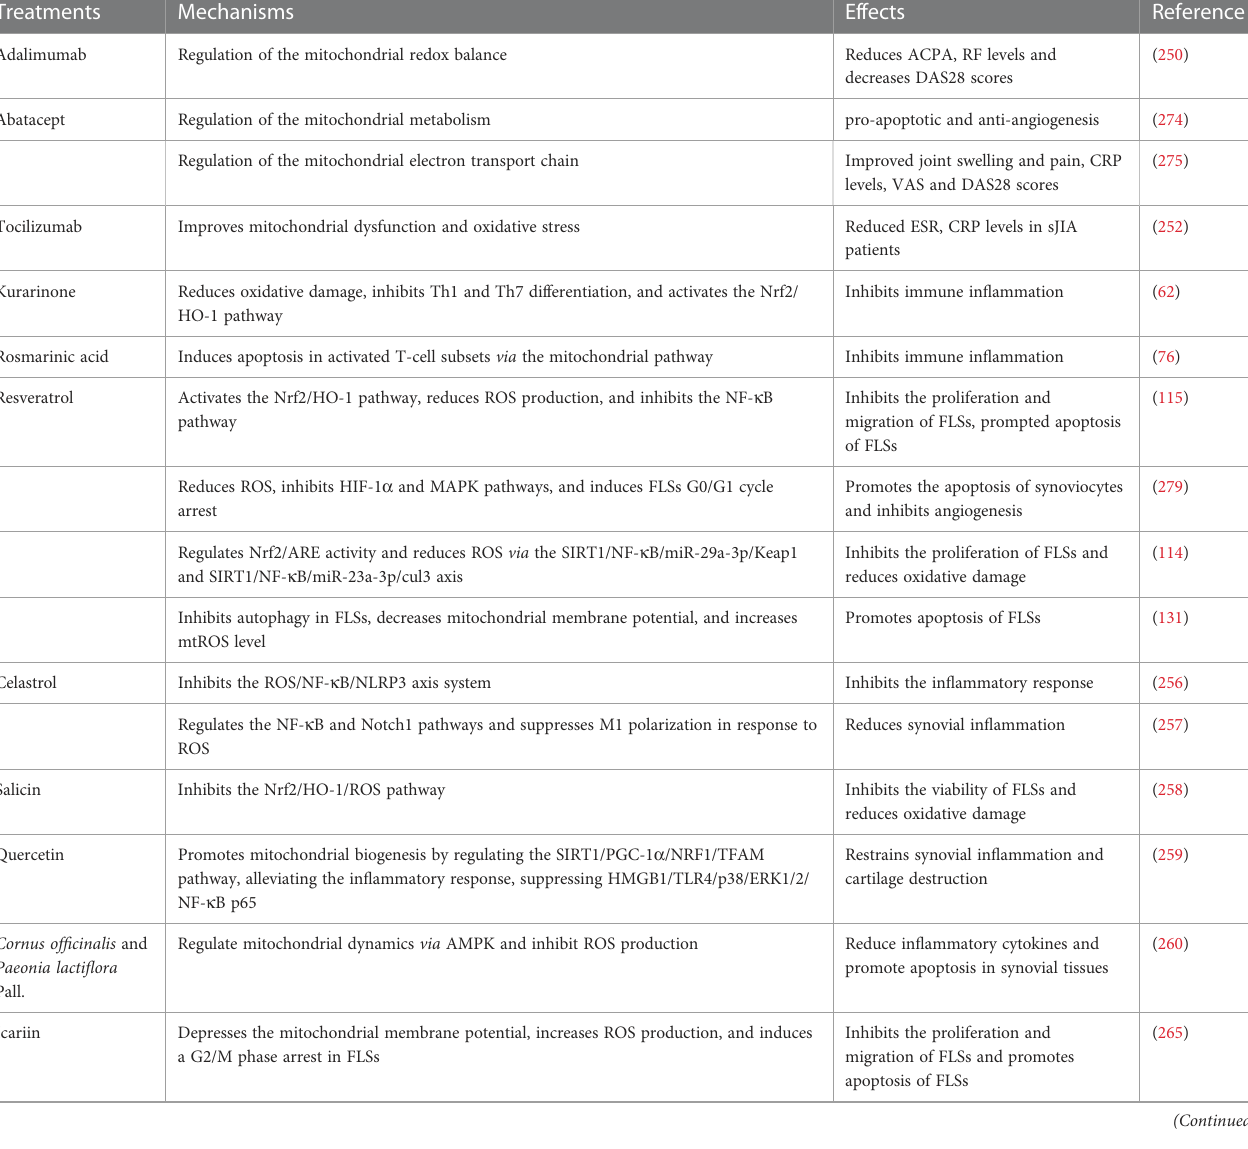
TABLE 1 Drugs used in RA treatment that act by regulating ROS or the mitochondria.